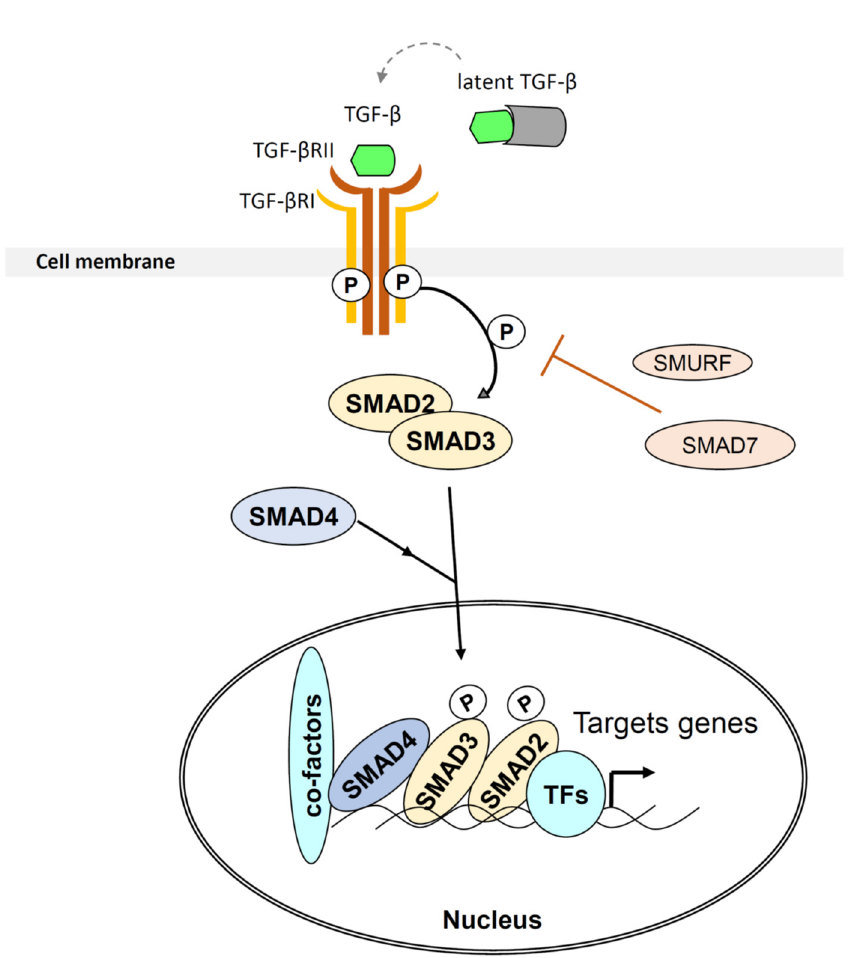
Figure 2. Canonical TGF- β signaling through its receptors and SMAD proteins. The release of active TGF- β from latent TGF- β complex likely involves the action of diverse proteases and interactions with integrins (such as α v β 6 or α v β 8, not shown). Active TGF- β is recognized by the TGF β type II